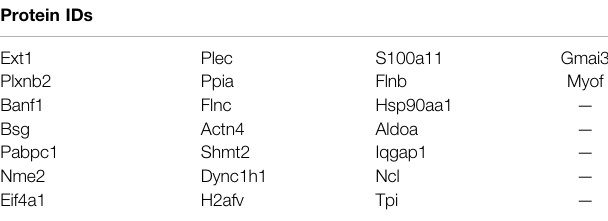
TABLE 3 | Ceramide-dependent PA-stimulated EV